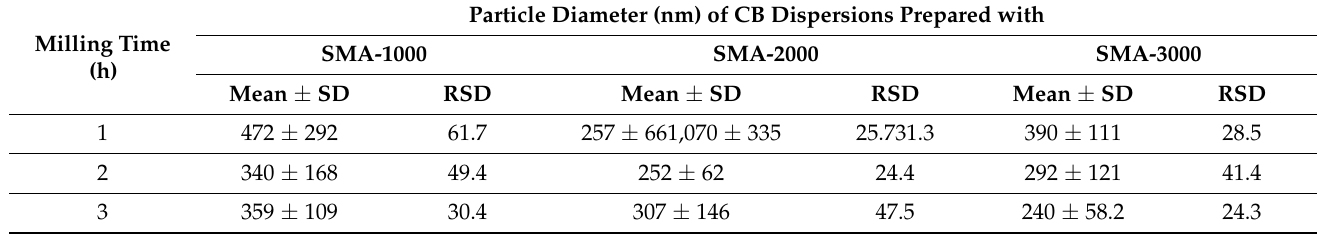
Table 4. Particle diameters determined by DLS for CB dispersions are shown in Figure